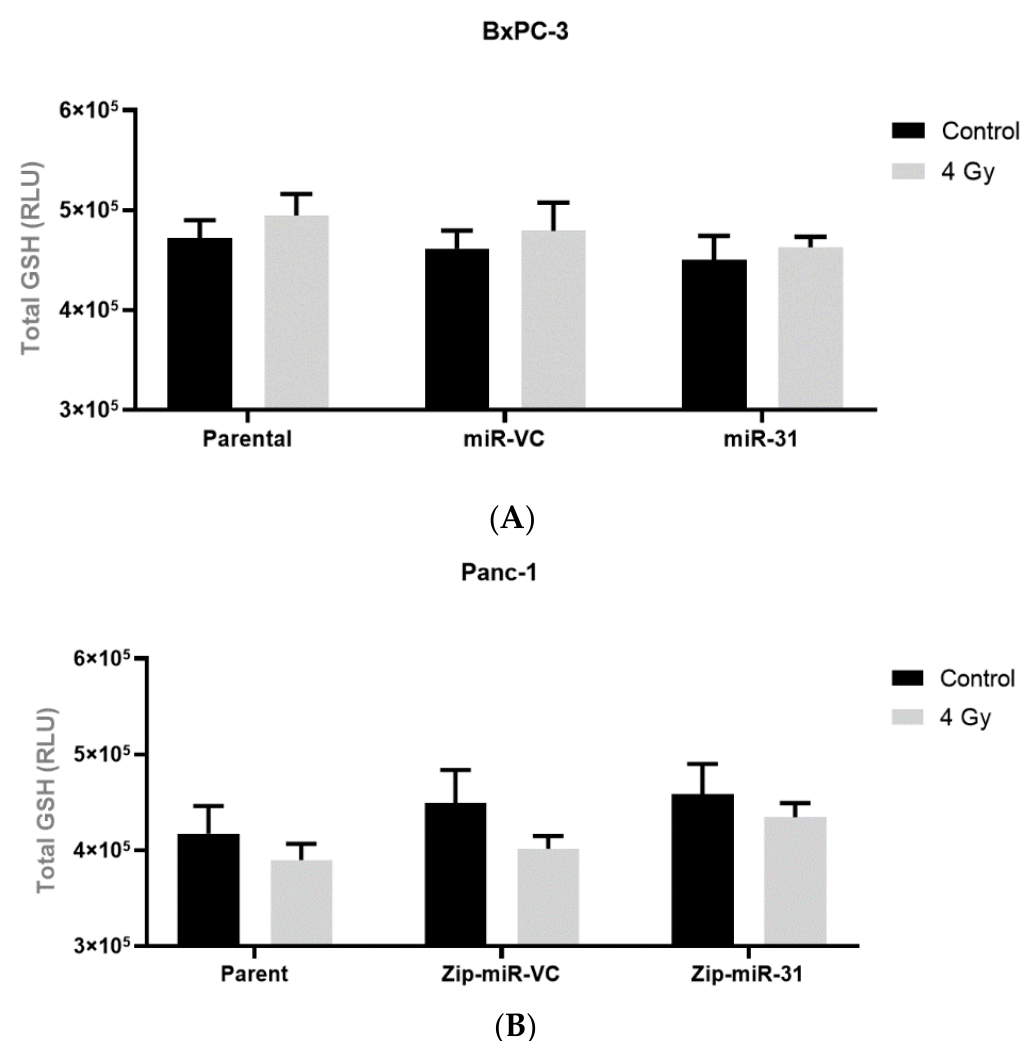
Figure 8. Manipulating miR-31 does not alter total glutathione (GSH) levels in PDAC cell lines. Total GSH in ( A ) BxPC-3 parental, miR-VC, and miR-31 overexpressing cells, and ( B ) Panc-1 parent, Zip-miR-VC and Zip-miR-31 suppressed cells, post-radiation with 0 Gy and 4 Gy. No significant differences were observed. Data are expressed as the mean ± SEM and were analyzed by a two-tailed paired t -test ( n = 3).